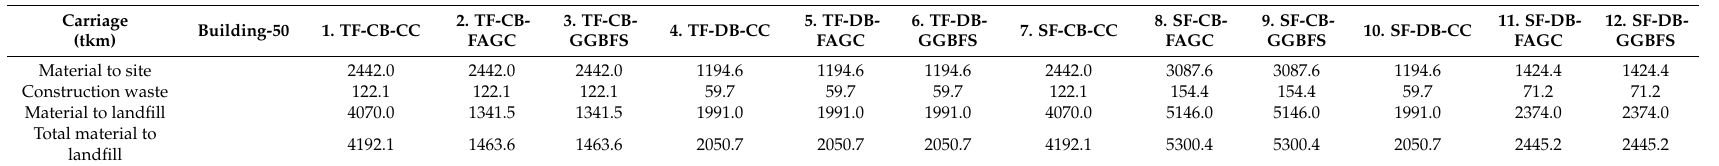
Table A4. Life cycle inventory of material transportation for the replacement stage of case study